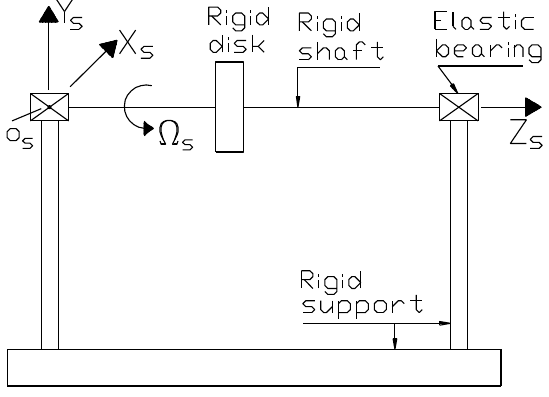
Fig. 1. A rigid rotor-elastic bearings-rigid support con fi guration.